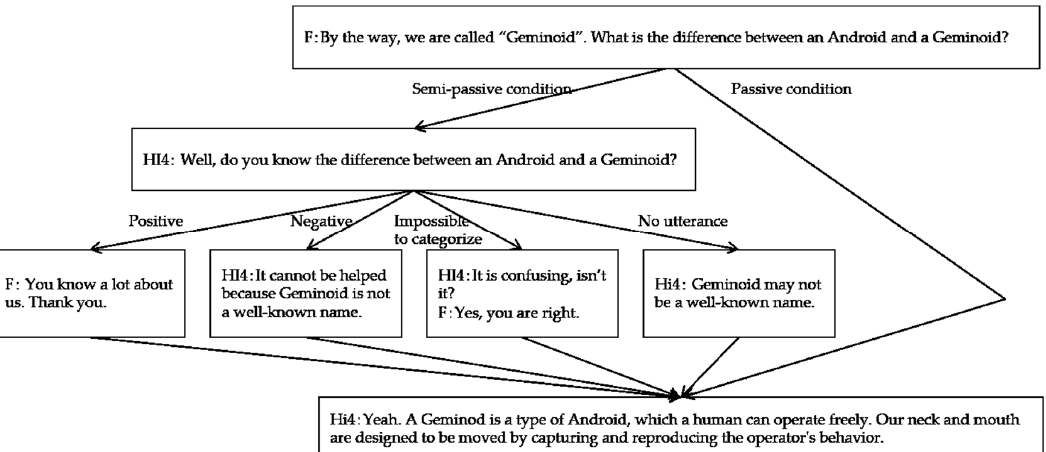
Figure 5. Example of the conversation.